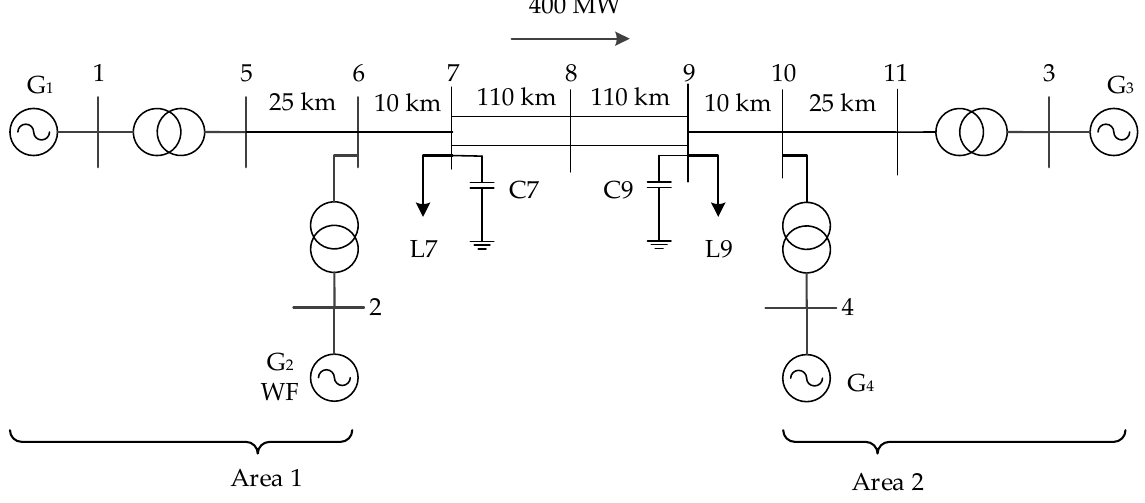
Figure 4. Schematic diagram of four-machine two-area system. Table 1. Control parameters of generators in the four-machine two-area system.